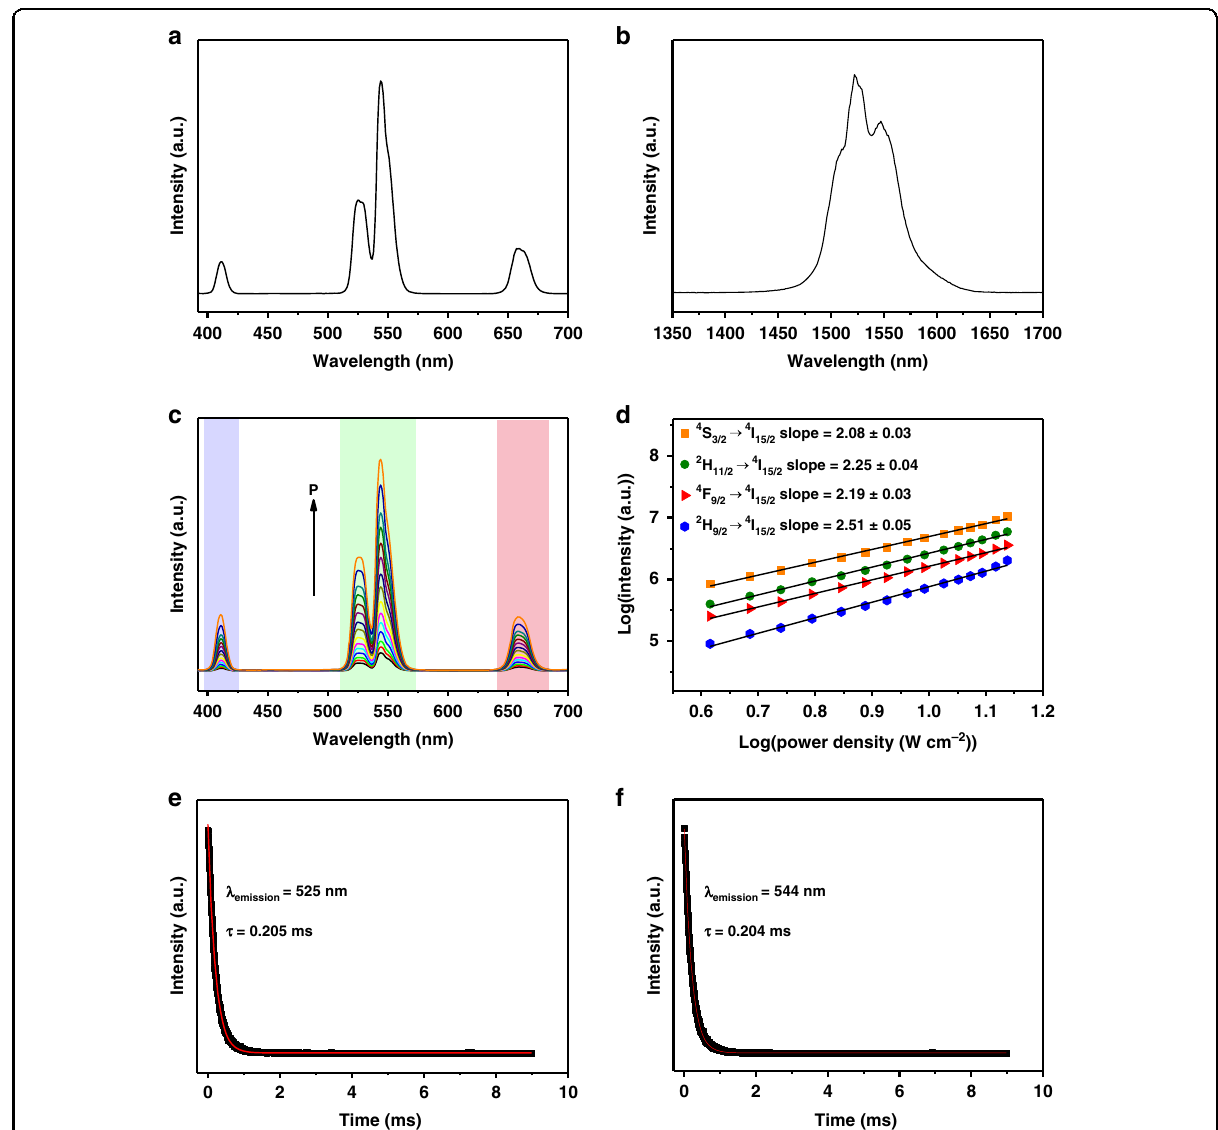
Fig. 4 Fluorescence spectra of NBFYE HNPs synthesized by adding 1.5 g PAA and 5 mL H 2 O to the reaction system under 980 nm irradiation. a UCL and ( b ) NIR-II spectra ( P = 4.85 W cm − 2 ). c UCL spectra with excitation laser power between 4.13 W cm − 2 and 13.73 W cm − 2 . d Pump power dependence of UCL intensity. Time-resolved fl uorescence decays of Er 3 + ions emission at ( e ) 525 nm and ( f ) 544